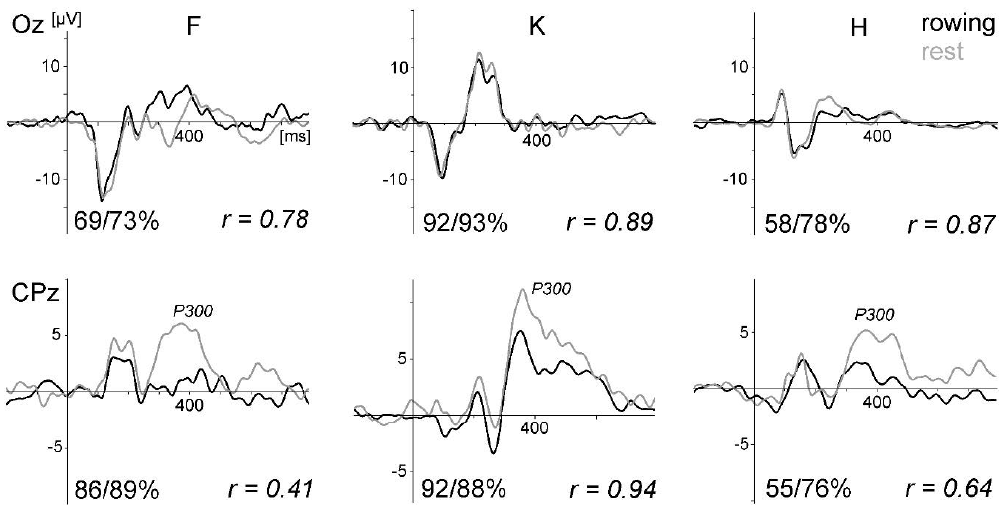
Figure 3. ERPs of the visual oddball task comparing rowing and rest for all three subjects (F, K, and H) of pilot Study 2. Upper graphs: VEPs evoked by the frequent checkerboard stimulus at electrode site Oz (average referenced). Below: the P300 waveform at CPz, which was larger during rest. The vertical line marks the stimulus onset. The numbers at the bottom of each graph present the percentage of artefact-free trials included in the averages for rowing and rest of the chosen electrode site and the correlation coe ffi cients. The high dropout rate for subject H was due to eye-blink / eye-movement artefacts. For subject F, the data loss at occipital sites was due to neck muscle activity. Deviant stimulus condition is not